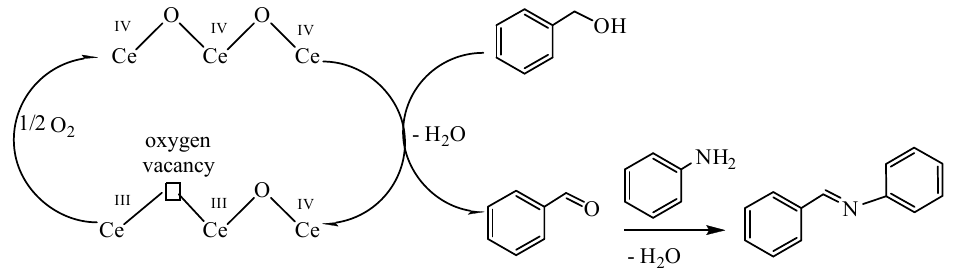
Scheme 3: Proposed mechanism for the imine synthesis over ceria . Scheme 3. Proposed mechanism for the imine synthesis over